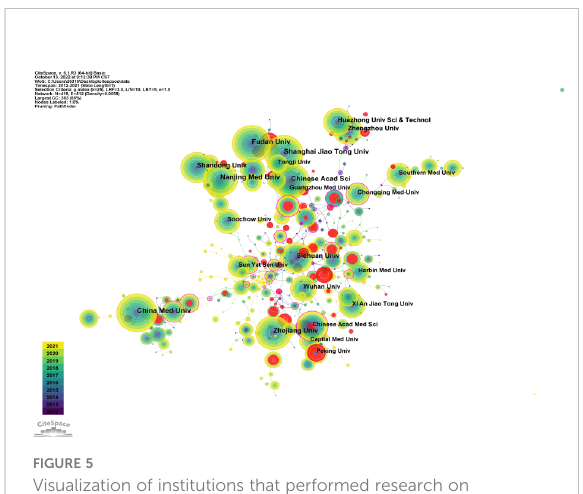
FIGURE 5 Visualization of institutions that performed research on autophagy in lung